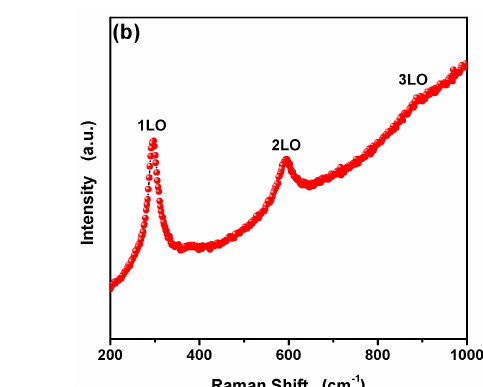
Figure 1. Transmission electron microscopy (TEM) ( a ), high-resolution TEM (HRTEM) ( b ) and ( c ) atomic force microscope (AFM) images of as-synthesized L-Aspartic acid (L-Asp)@CdS QDs, ( d ) statistical analysis of the heights of L-Asp@CdS QDs measured by AFM.